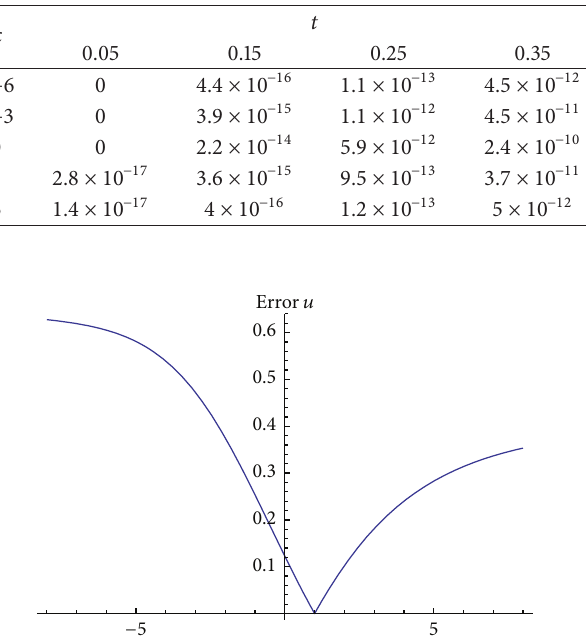
Table 1: Absolute error |𝑢(𝑥,𝑡)−𝑢 𝑛 = 11 .